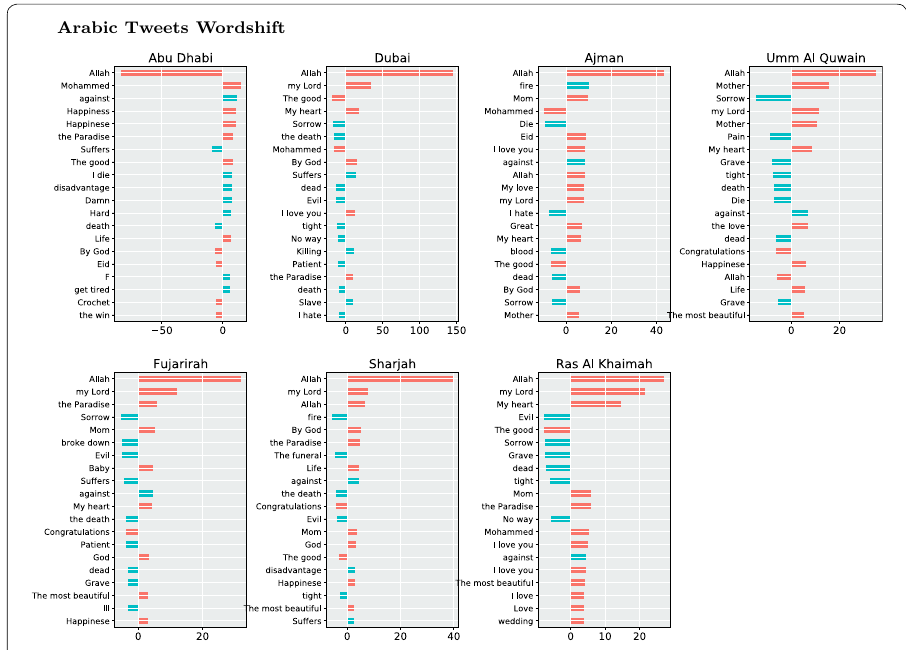
Fig. 4 Arabic word shift graph (with reference to whole UAE) for the seven